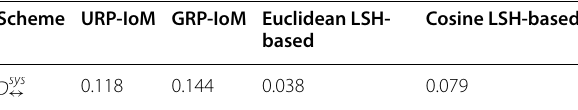
Table 7 Quantitative evaluation of cancelable biometrics of CASIA-FaceV5 database